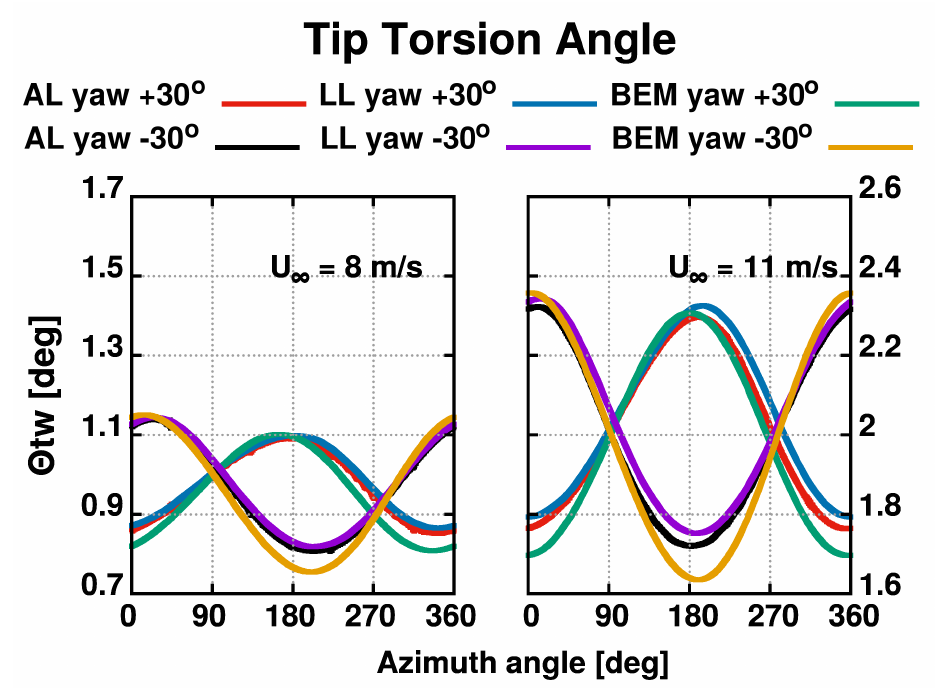
Figure 30. Torsion angle of blade tip at 30 ◦ yawed wind speed at 8 and 11 m/s.